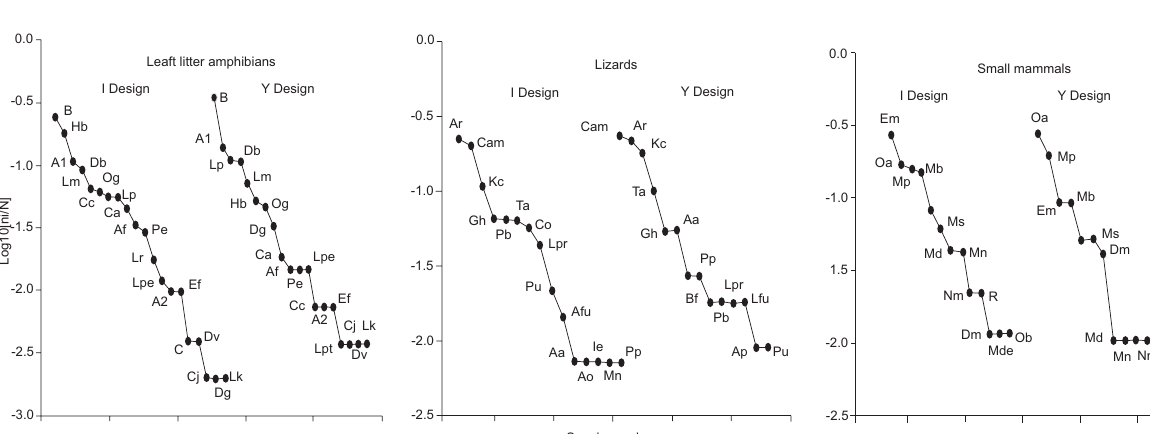
Figure 5. Leaf litter amphibian, lizard and nonvolant small mammal species rank-abundance curves (Whittaker plots) registered by the different pitfall trap design (I and Y). Abbreviation of species names are given on table